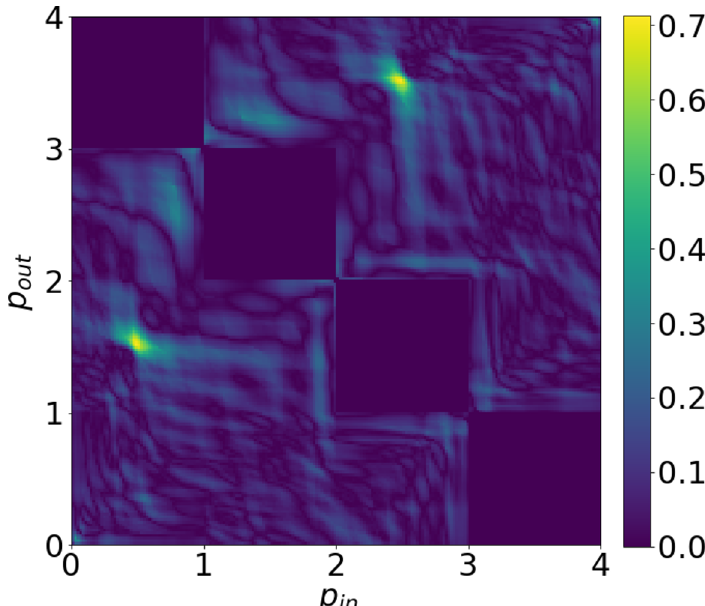
Figure 19 . Results from applying the wombling procedure of section 6 to the illustrative point data example used in the previous sections ( N = 500 points generated from (2.5) with ρ = 5 ). Delaunay-averaged gradient vectors which were defined in (3.10). In constructing the heat map, we sampled the ( p in , p out ) parameter space on a 200 by 200 grid with step size 0.02 and then